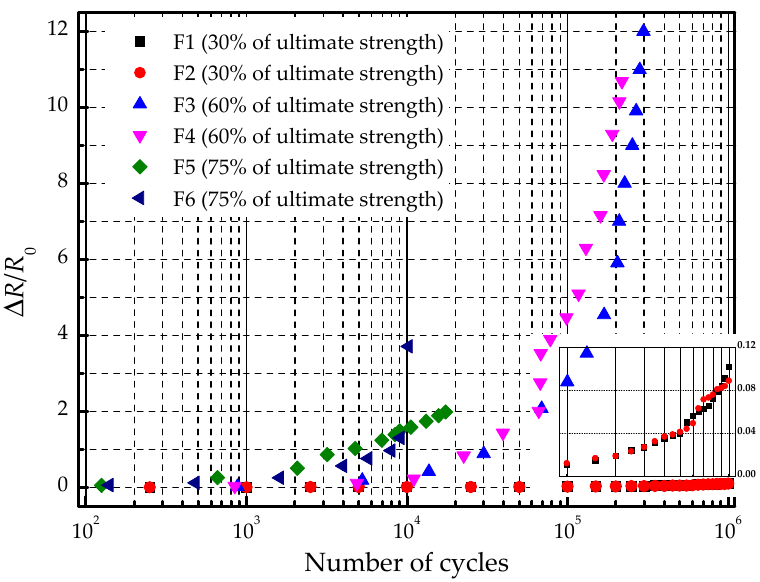
Figure 15. Variation of electric resistance along with the number of mechanical cycles.